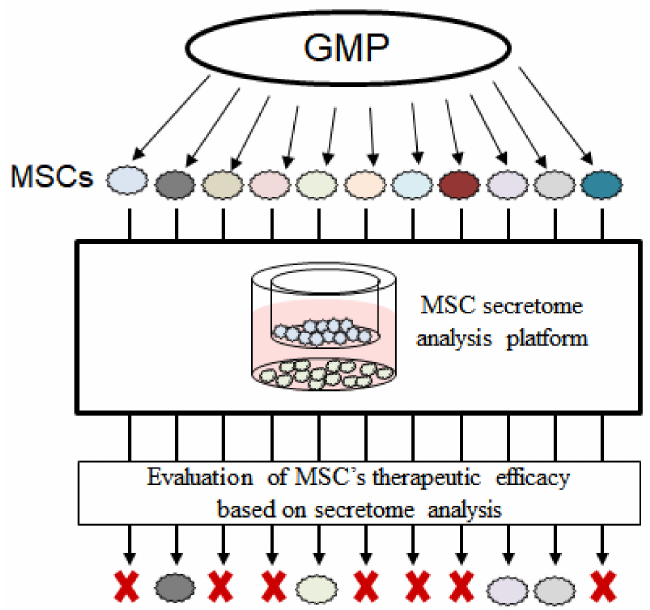
Figure 6. Application of MSC secretome analysis platform to evaluate the therapeutic efficacy of MSCs. Based on the secretome profile, MCSs with a better therapeutic effect could be determined and used to treat patients. Cross marks indicate that the MSCs are considered to have poor efficacy, based on secretome